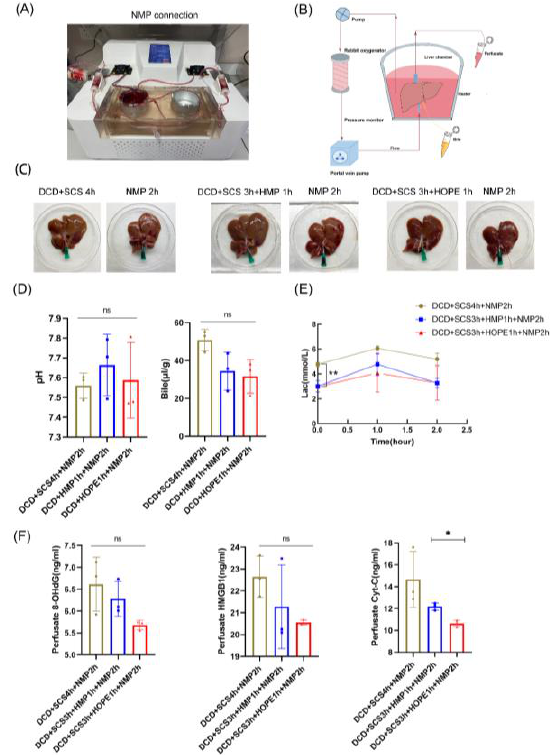
Figure 7. NMP following the hyperthymic storage/perfusion ( n = 3). ( A ) NMP connection system. ( B ) Schematic representation of NMP devices. ( C ) liver appearance using three different hyperthymic storage or MP methods in perfusion series 2. ( D ) Bile pH and production. ( E ) Lactate concentration during NMP. ( F ) ELISA kit of 8-OHdG, Cyt C, and HMGB1 in perfusate ( n = 3 independent experiments for C – F ). Mean ± SD, N.S., p > 0.05, * p < 0.05, ** p < 0.01.